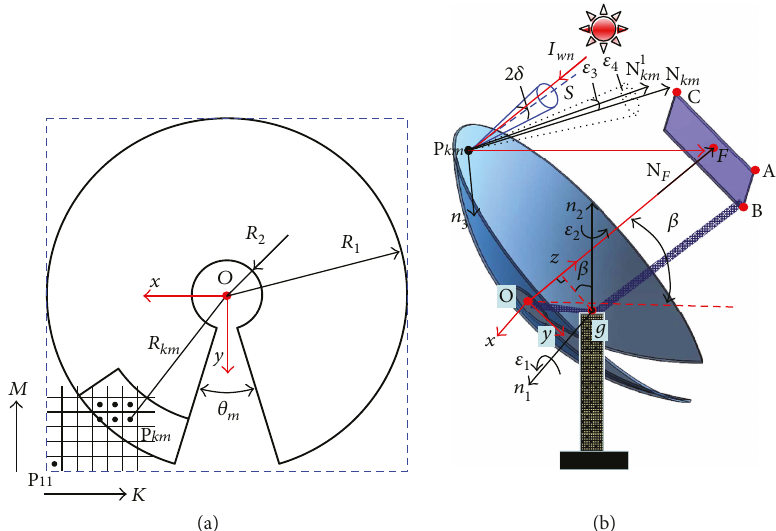
Figure 2: (a) Geometry parameters and mirror discrete of the dish concentrator and (b) schematic diagram of the tracking error and mirror slope error of the dish